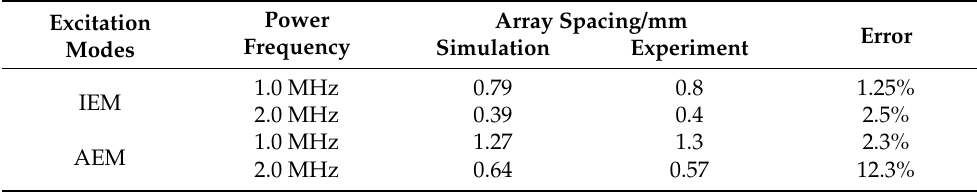
Table 2. Comparison of array spacings between the simulation and experimental results.